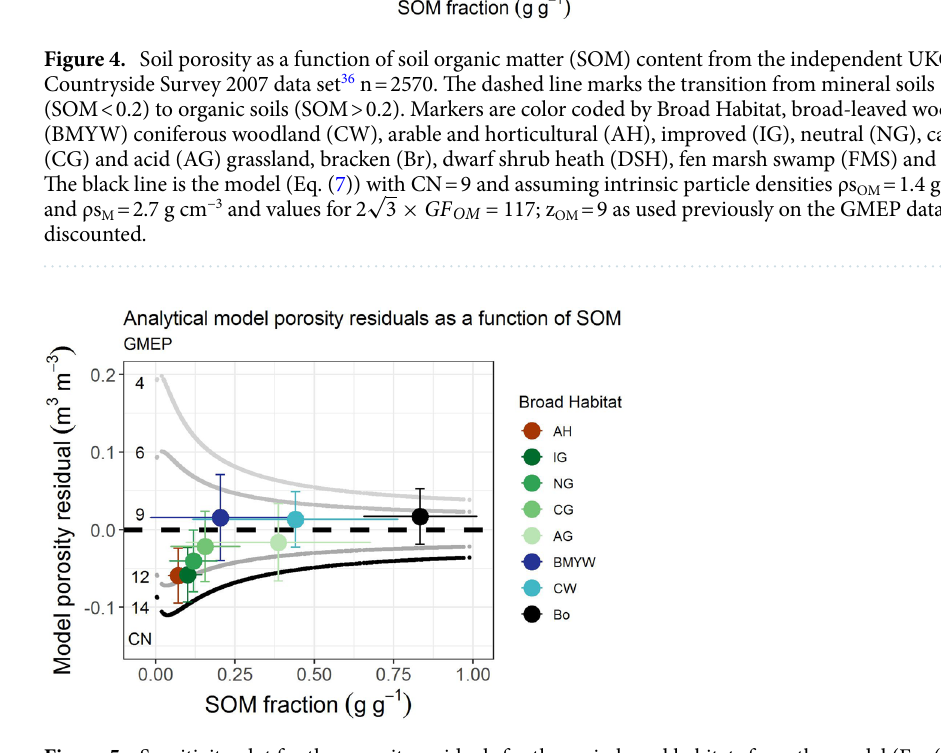
into dryland or low organic matter soils would increase the dominance of particle size for example, as found by others for low SOM soils 16,33 . Exploration of the model residuals. Figure 5 explores how soil porosity in different habitats diverges from the analytical model. We use Eq. (7) (Fig. 3D) to explore the residuals as a function of SOM, colored by broad habitat (BH). The porosity residuals plot generated is bounded by the analytical model predictions for different coordination numbers (Eq. (7)). The abscissa corresponds with CN = 9, and the upper grey lines CN = 6 and 4, while the lower darker lines are CN = 12 and 14. The response for each BH and their respective standard deviations are shown by the error bars (see Fig. S3 for the raw scattered data). We would expect that if there is no bias that the soils would be randomly clustered around the zero line (CN = 9). Those exhibiting higher porosity